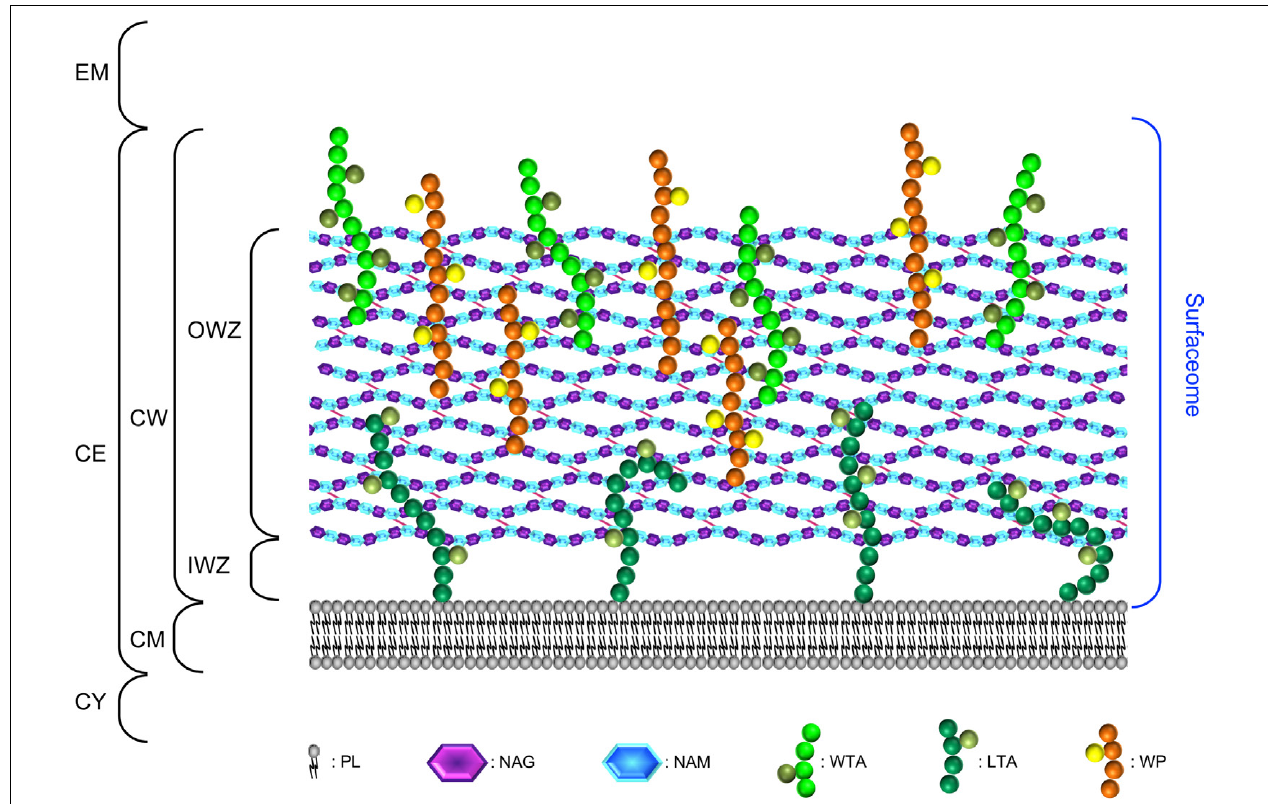
FIGURE 1 | The surfaceome of parietal monoderm bacteria with respect of the organisation and composition of the cell envelope. The cell envelope (CE) of parietal monoderm bacteria is composed of a biological membrane acting as selective permeable barrier, i.e., the cytoplasmic membrane (CM) and a cell wall (CW) providing some resistance to mechanical stresses (e.g., internal turgor pressure) but also somehow acting as a philtre. While the CM is composed of phospholipids (PLs), the CW can be further subdivided into the inner wall zone (IWZ) and the outer wall zone (OWZ). The OWZ constitutes the main CW fabric. It is composed of N -acetylglucosamine (NAG) and N -acetylmuramic acid (NAM), both constituting the peptidoglycan (PG) with which wall teichoic acids (WTAs), and wall polysaccharides (WPs) are anchored. Lipoteichoic acids (LTAs) are anchored to the CM and protrude from the CM. As revealed by electron microscopy studies and contrary to the OWZ, the IWZ is a thinner zone of low density most certainly devoid of most cross-linked polymeric CW network, except LTAs and some proteins, e.g., lipoproteins (Matias and Beveridge, 2005, 2006); because this zone is not strictly bounded by two biological membranes like in diderm bacteria, the IWZ resembles but cannot be considered as a periplasm sensu stricto , i.e., it presents some analogies but no homology (Buist et al., 2008; Chagnot et al., 2013). In addition to the proteins present both at the CM and CW and that are not depicted here for clarity (see text and Figures 4–6 ), these different macromolecular molecules exposed on the external side of the CM constitute the surfaceome in parietal monoderm bacteria. CY, cytoplasm; EM, extracellular